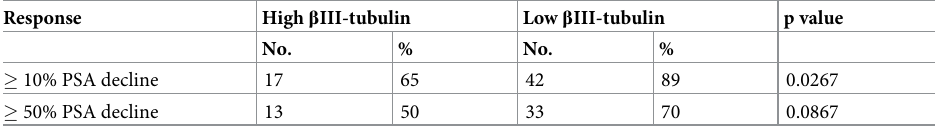
Table 3. Response to docetaxel treatment per β III-tubulin expression status.